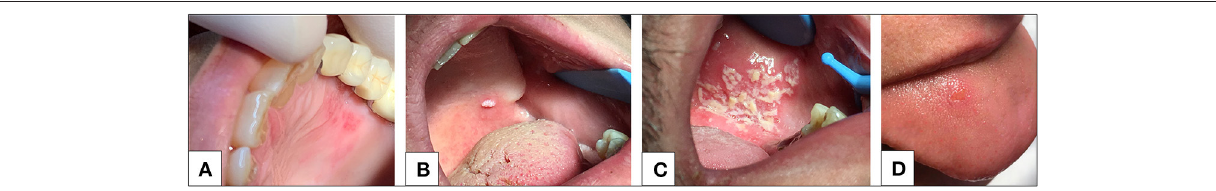
FIGURE 2 | (A) Herpetic-like oral lesion. (B) Oral mucosal verruca lesion. (C) Opportunistic infection (candidiasis) in patient affected by HIV. (D) Unspecific ulcerous lesion in a SARS-CoV-2 infected patient. Image 2D is a case courtesy of Chaux-Bodard et al. (9).